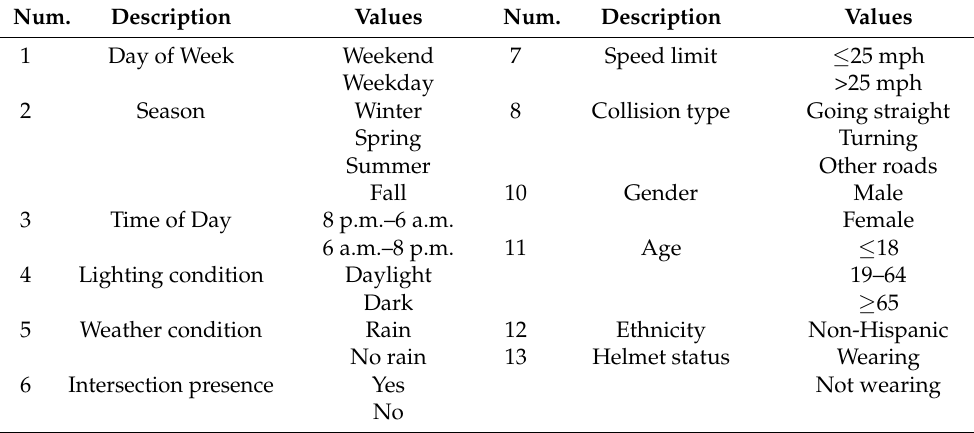
Table 1. Description of the logistic regression independent variables.